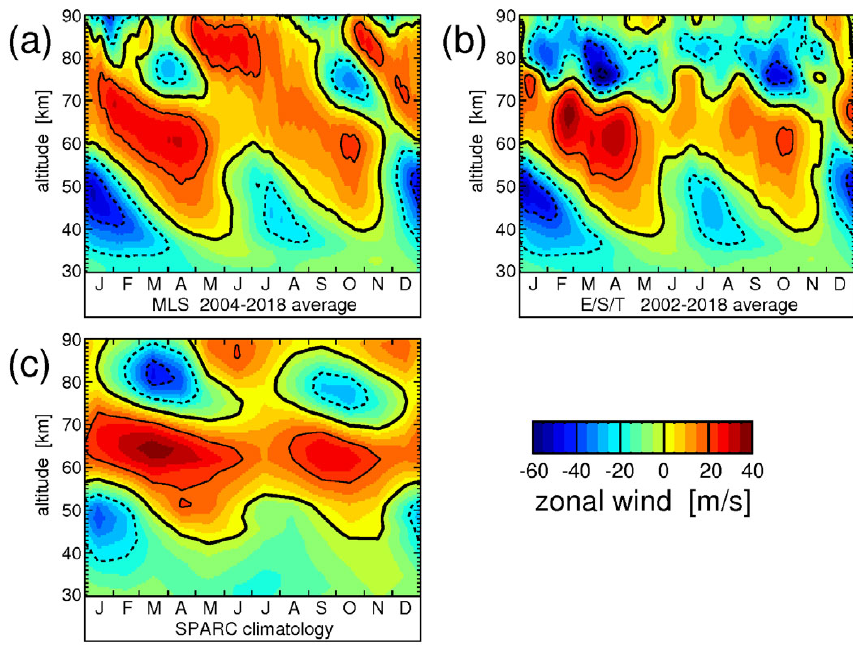
Figure 3. Typical seasonal variation of the zonal-average zonal wind averaged over 10 ◦ S–10 ◦ N and the time period 2002–2018 for two data sets that use satellite data. Panel (a) is a data set that uses ERA-Interim winds at altitudes < 35km, MLS quasi-geostrophic winds at altitudes > 45km, and a smooth transition between ERA-Interim and MLS winds between 35 and 45km. Panel (b) is a data set called “E/S/T-winds” that uses ERA-Interim winds at altitudes < 35km, SABER quasi-geostrophic winds at altitudes 45–75km, and TIDI cold side winds, i.e., direct wind observations, at altitudes above 80km. Between 35 and 45km, there is a smooth transition between ERA-Interim and SABER winds. The gap between 75 and 80km is interpolated. In (a) and (b) , MLS, SABER and TIDI winds are an average over ascending and descending orbit branches. For comparison, (c) shows the corresponding zonal winds of the SPARC climatology (see Swinbank and Ortland, 2003; Randel et al., 2002, 2004). Overlaid are contour lines of the respective wind data set. Contour line increment is 20ms − 1 . The zero wind line is highlighted in bold solid contour lines, and westward (eastward) winds are indicated by dashed (solid) contour